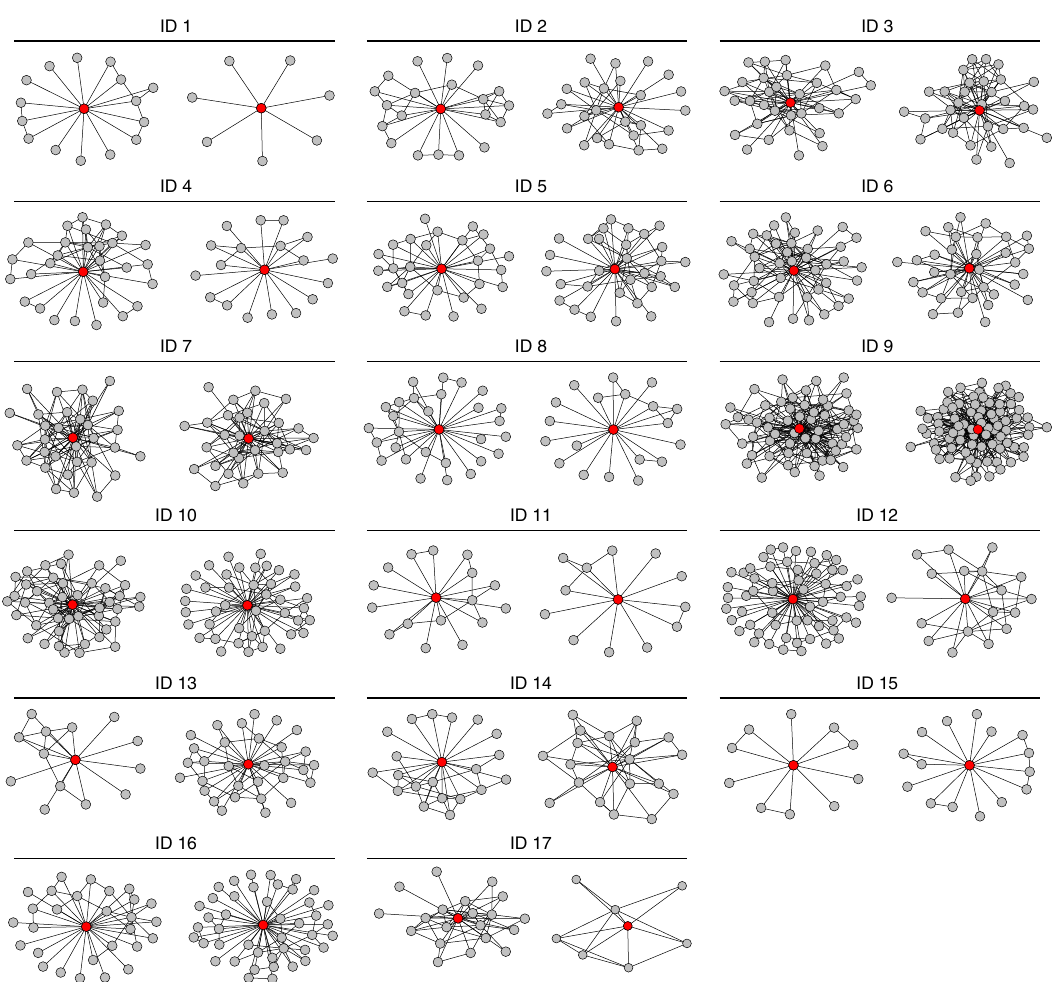
Fig. 2 Egocentric networks of community medicine distributors. Figure 2 presents 34 egocentric networks where the ego of interest is the community medicine distributor (CMD). There were two CMDs per village and the numbers above the graphs correspond to the village ID. These plots are not ordered by any descriptive or network characteristics. The subgraphs were extracted from full village networks and each neighbor of the CMD and all corresponding edges between those neighbors were included. Vertices in these networks are households and edges indicate friendship ties between households. The CMD household is the red vertex in the center of the subgraph. Wide variation in clustering — the frequency that friends of CMDs also were friends — is easily observable across villages. For example, the star and star-like ego networks in village ID 1 have clustering coef fi cients of 0 and 0.067 and the ego networks of village ID 7 have clustering coef fi cients of 0.168 and